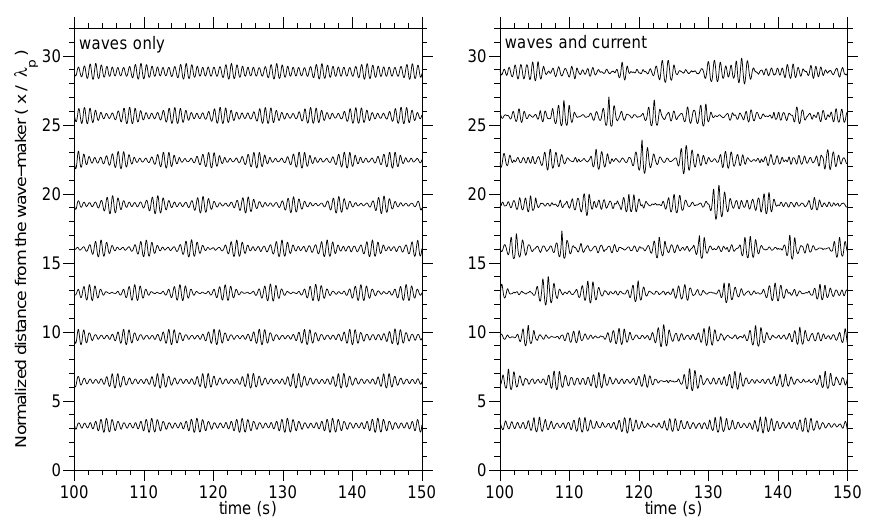
Fig. 4. Surface elevation along the tank: regular wave experiment. Regular waves are defined with a carrier wave with period of 0.8s and steepness ka = 0 . 1 plus two perturbations with an amplitude of 0 . 25 a and a bandwidth of 1k = 0 . 25. The mean wave direction is 110deg and the current speed is 0.2ms − 1 .